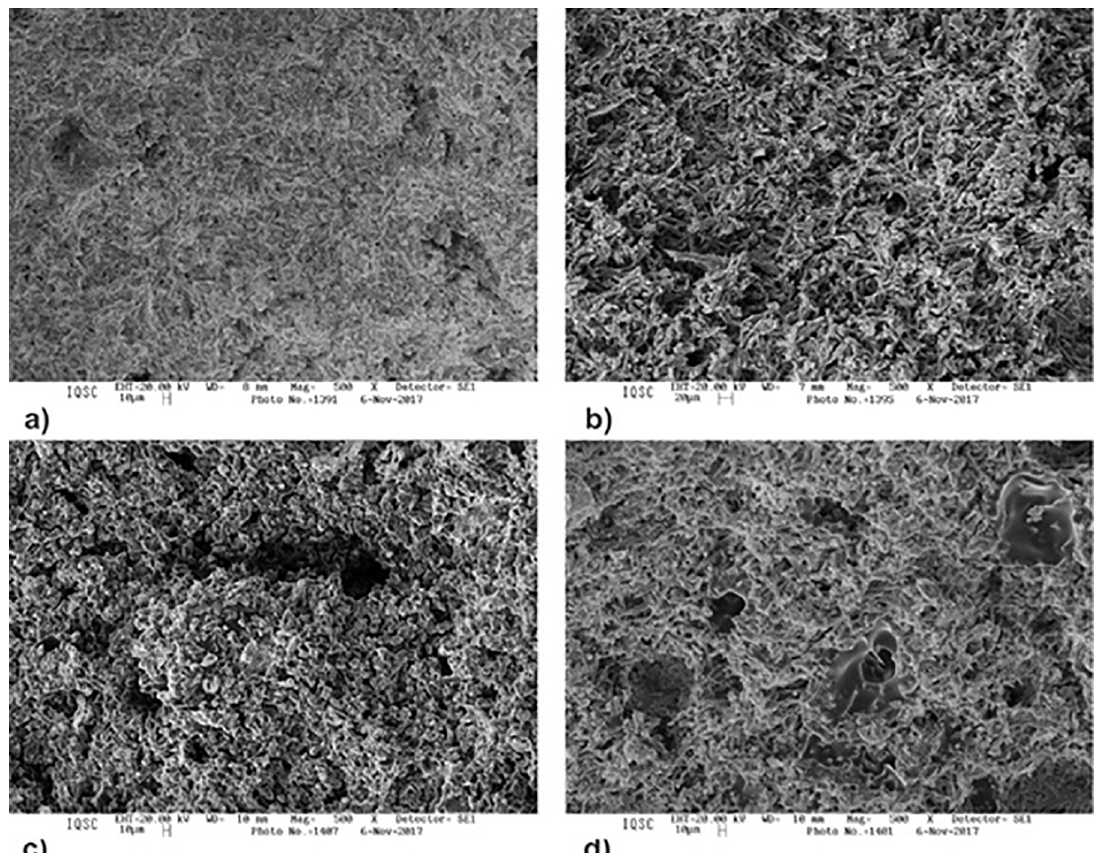
Figure 3. Matrix - 500X Magnification: (a) without polymer. Modified matrix with 10%: (b) EVA; (c) VA/VL/VC; (d)